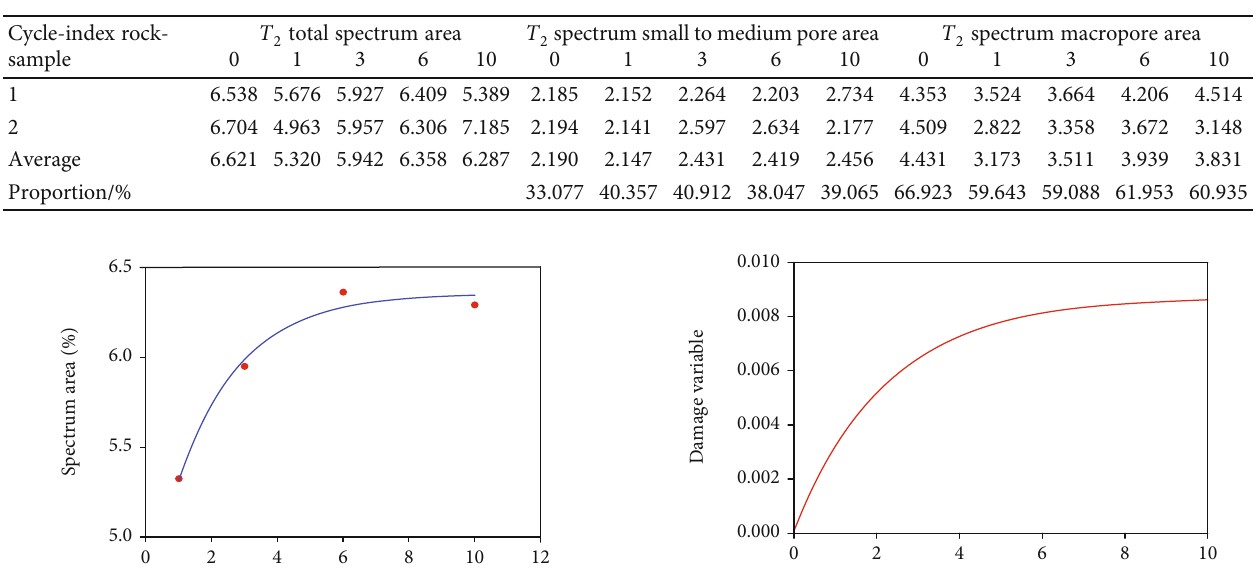
ff erent wet and dry cycles.